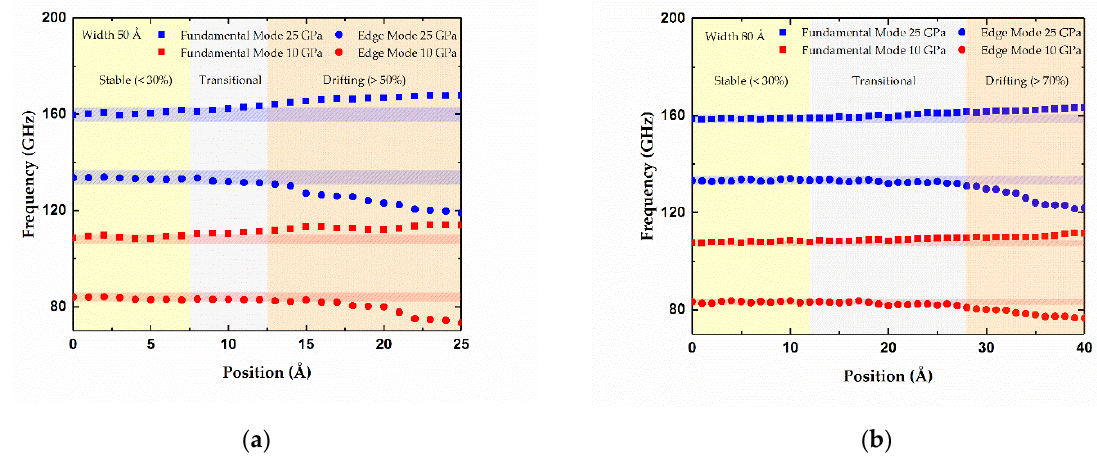
Figure 5. Resonant frequencies of the fundamental modes and edge modes versus the adsorbate positions along the width of graphene sheets. ( a ) Width of the graphene sheet is 50 Å. ( b ) Width of the graphene sheet is 80 Å.